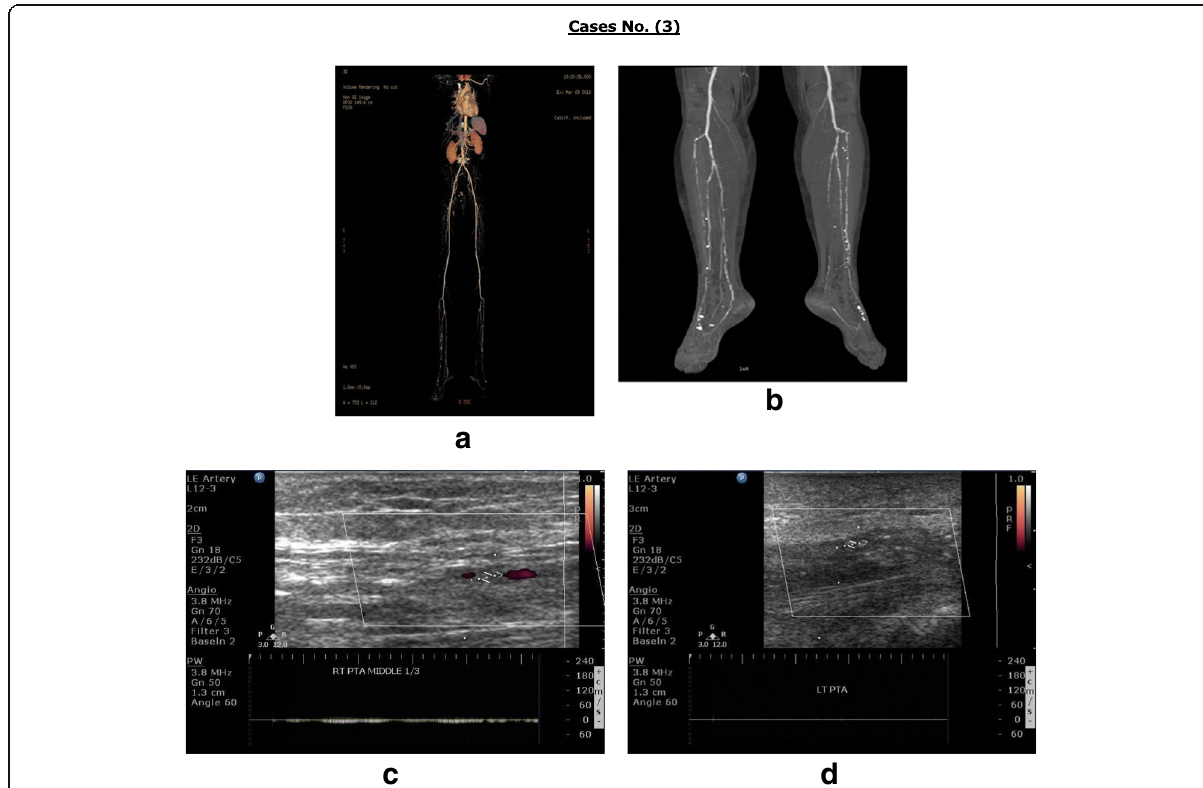
Fig. 3 Female patient aged 57years, diabetic, not hypertensive, cardiac, or smoker. a Bilateral below-knee intermittent opacification. b Multiple athermanous plaques below the knee that cause stenosis but less than 50%. c Attenuated right side PTA with weak venous-like waveform. d Attenuated left side PTA with multiple athermanous